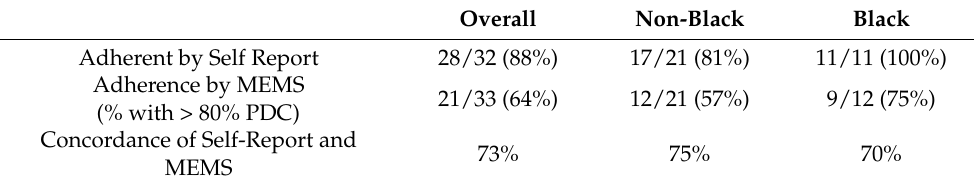
Figure 4. Post-intervention medication adherence by MEMS data (percentage of days covered). Note: Larger filled markers represent group means. Table 2. Comparison of MEMS cap to self-report adherence data by race.